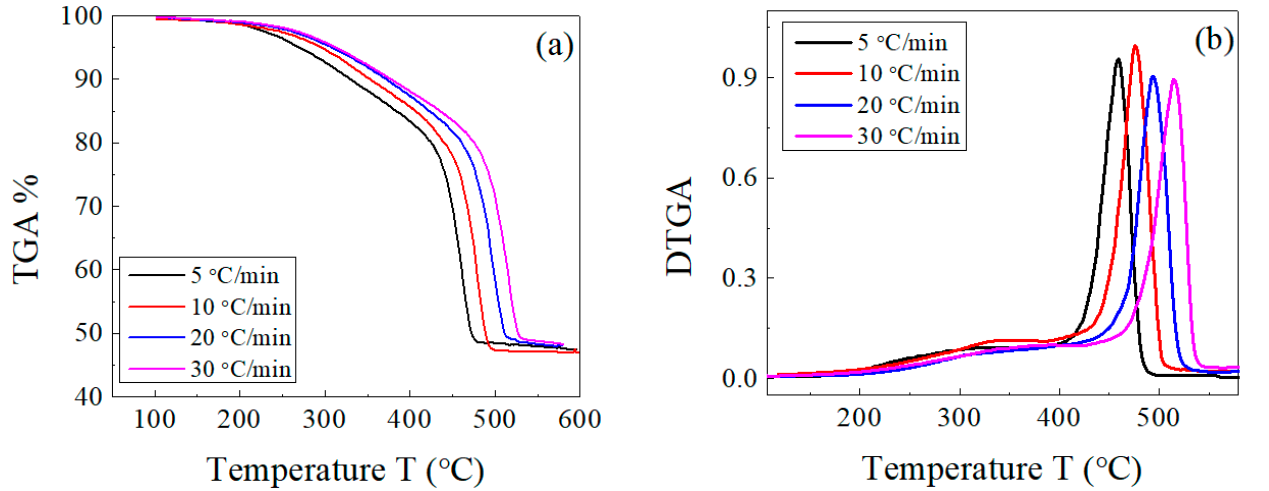
Figure 4. ( a ) TGA and ( b ) DTGA curves of EPDM host composite loaded with 100 phr lead powder at different heating rates of 5, 10, 20, and 30 °C/min.